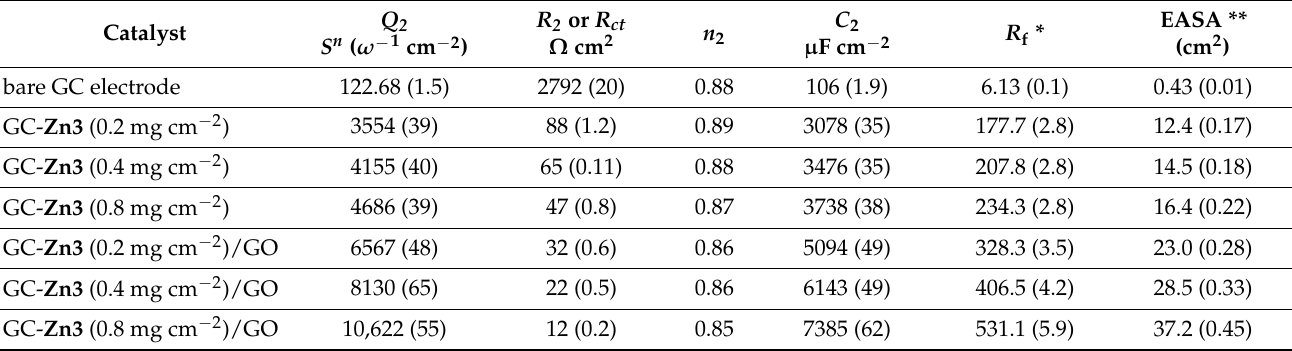
Table 5. Mean value (standard deviation) of the impedance parameters recorded for the investigated GC-loaded Zn3 catalysts (unsupported and supported on GO) in a comparison with bare GC electrode. Measurements were conducted in an aqueous deaerated KOH solution (0.1